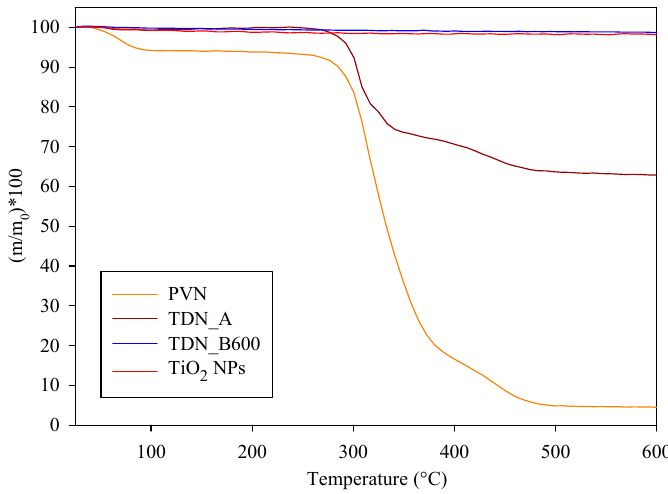
Figure 5. TGA curves of samples after polymer removal processes of TDN coated at 200 °C.